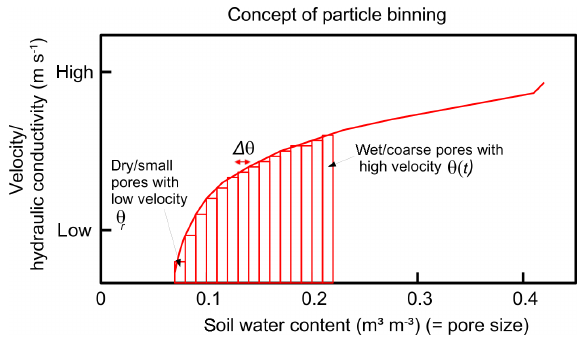
Figure 1. Concept of particle binning. All particles within a grid element are subdivided into bins (red rectangles) of different pore sizes. Depending on their related bin, the particles travel at different flow